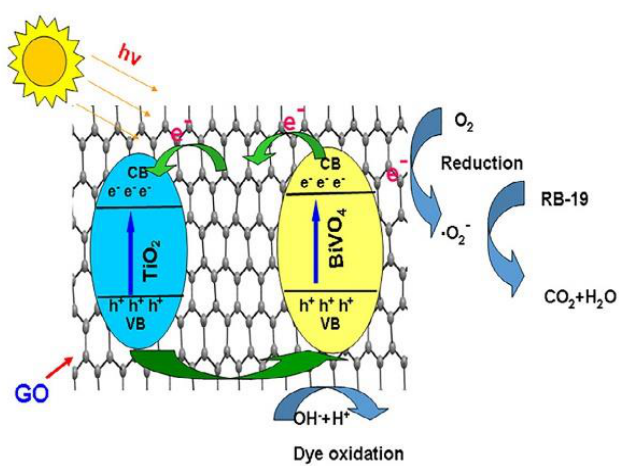
Figure 6. Photodegradation mechanism of BiVO 4 /TiO 2 /GO photocatalyst. Reprinted with permission from [74]. Copyright 2017, Elsevier.